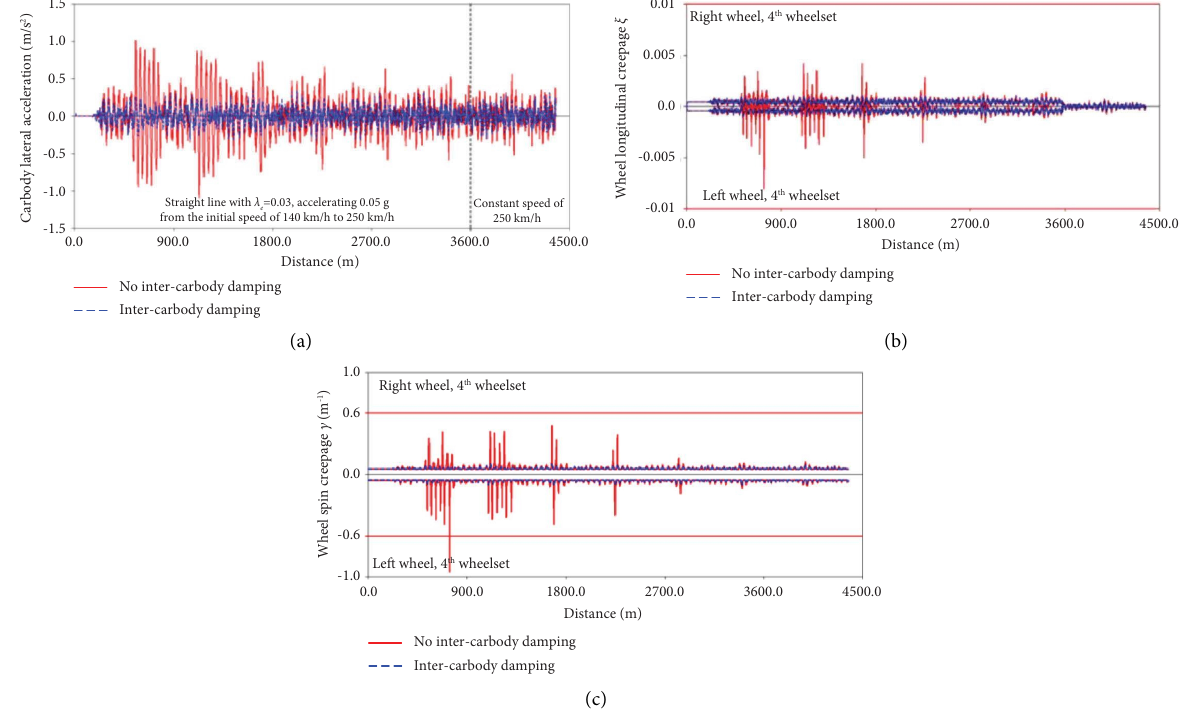
Figure 8: Efective assessments of MC03 under starting/braking conditions. (a) Lateral acceleration contrast at the rear-right point on the car body foor. (b) Wheel longitudinal creepage ξ . (c) Wheel spin creepage c